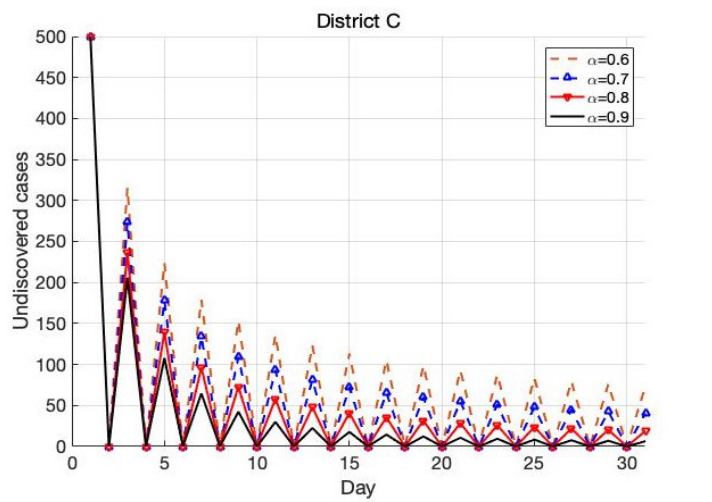
Figure 15. Model results for infected